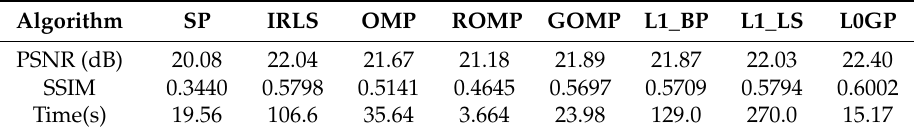
Table 1. The quantitative results of different algorithms.